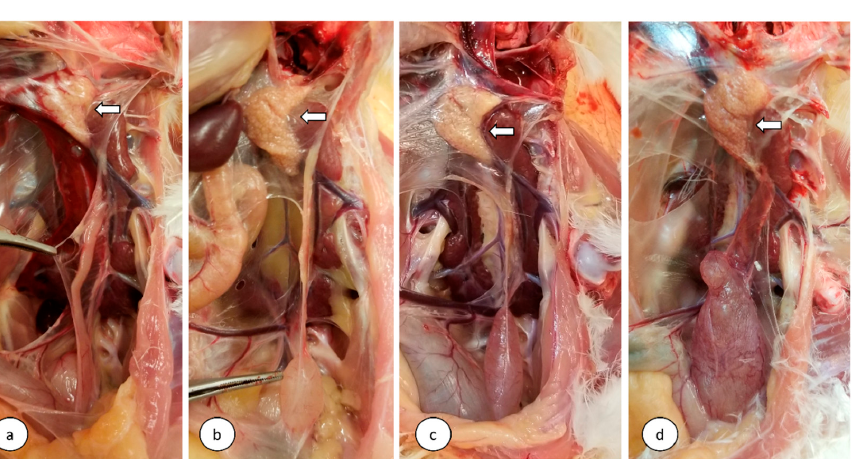
Figure 5. Comparison of the cystic lesions in the oviduct at 112 dpi (16 weeks) following infection at 1-day of age. ( a ) Control normal oviduct, ( b ) moderate cystic lesion, ( c ) marked cystic lesion, and ( d ) severe cystic lesion. Open arrows indicate the immature ovary.